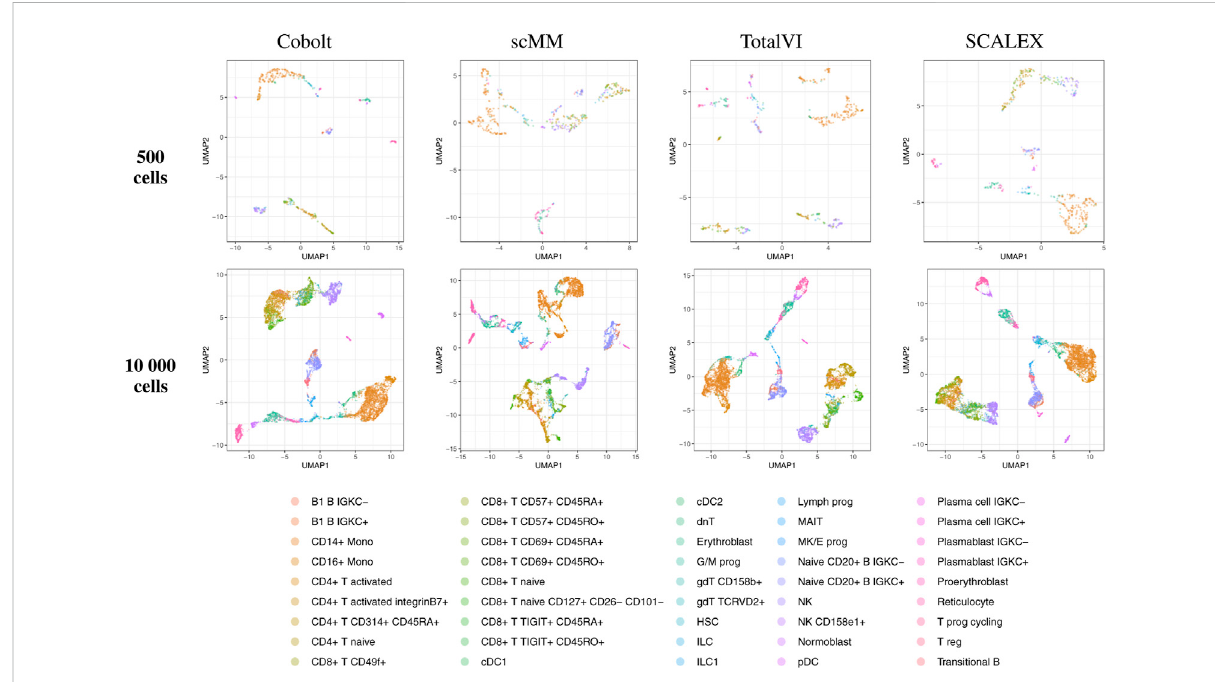
FIGURE 5 UMAPofthe10-dimensionallatentspaceofCobolt,scMM,TotalVI,andSCALEXbasedon500(top)and10,000(bottom)cellsofoneexemplary subsample from the CITE-seq dataset each. The color coding corresponds to manually annotated cell types as provided by Luecken et al. (2021a). Thefollowingcelltypesarenotpresentinthe500cellsample:CD4 + TCD314+CD45RA+,CD8 + TnaiveCD127+CD26 −